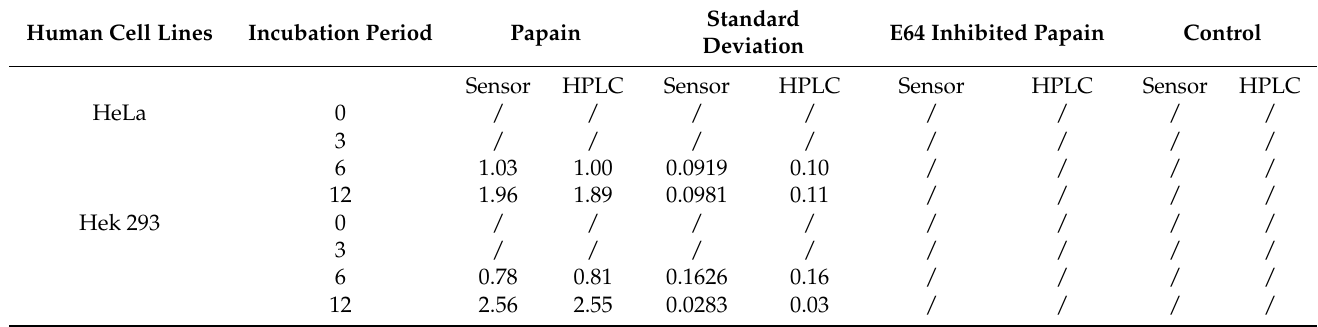
Table 2. The concentrations of UA obtained using the developed amperometric method (sensor) and HPLC as the reference method after the incubation of HeLa and HEK293 cells with papain. Human Cell Lines Incubation